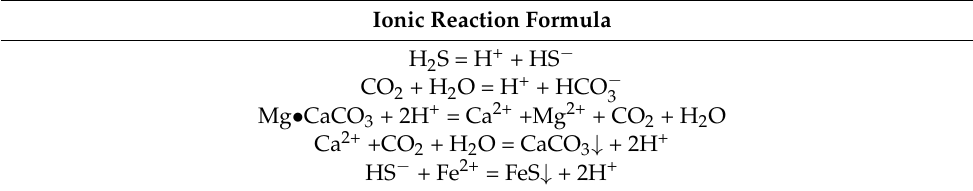
Table 2. Microscopic ion reaction process of water–rock reaction in carbonate sour gas reservoirs.